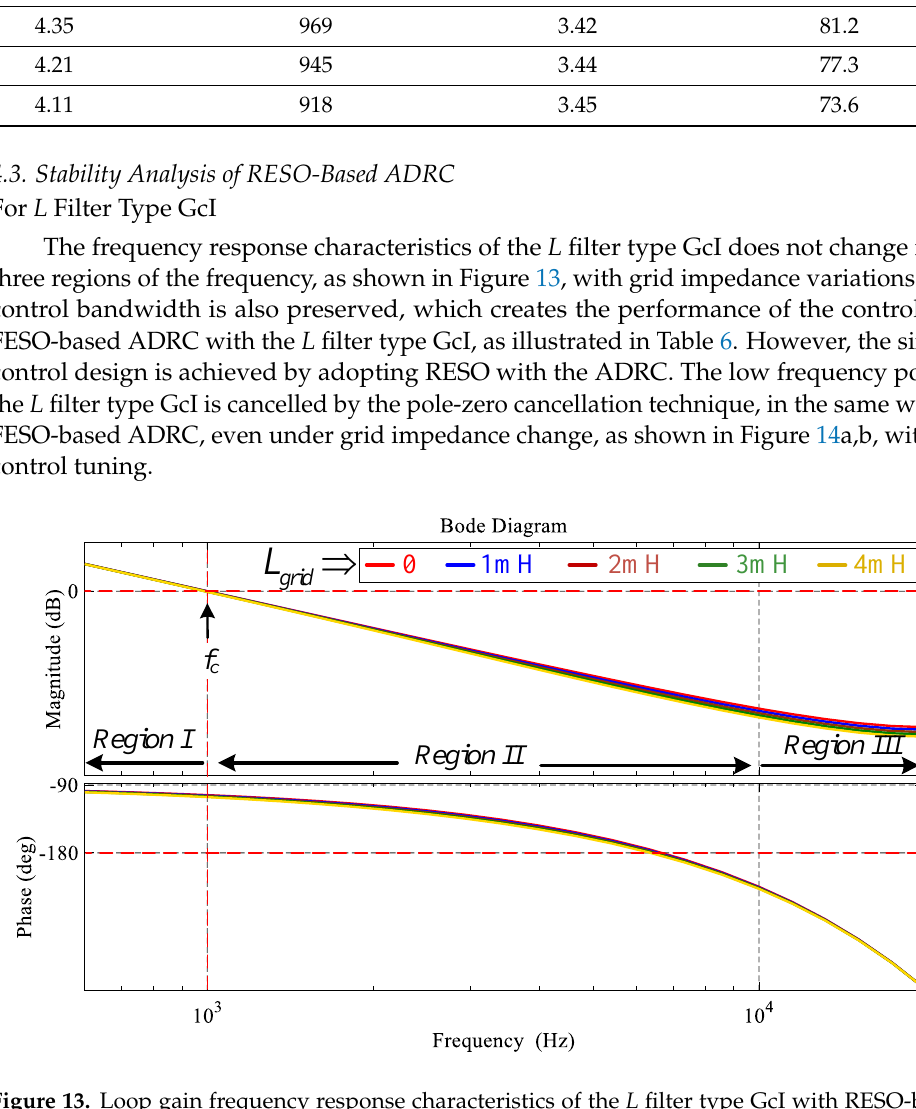
Table 5. Stability Analysis of FESO Based ADRC for the LCL Filter Type GcI.